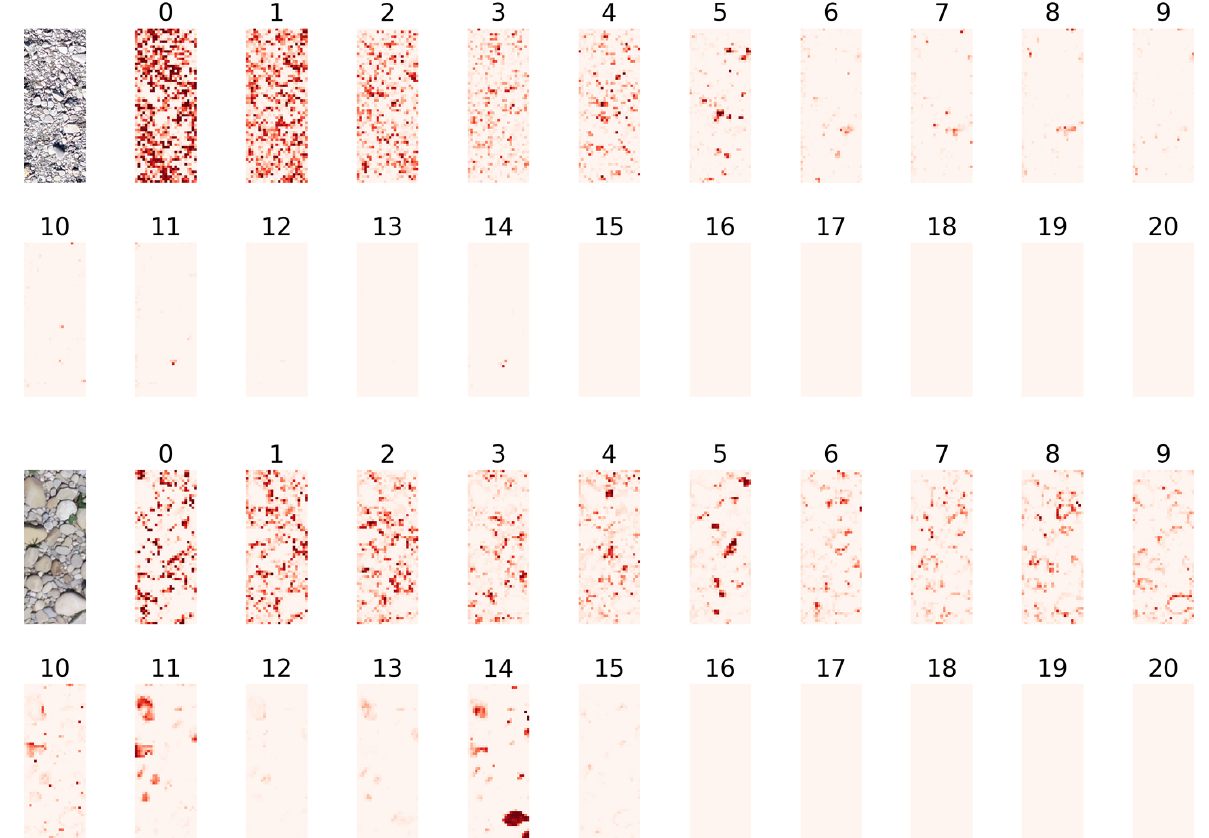
Figure 10. Activation maps after the last convolutional layer for two examples. Each of the 21 maps corresponds to a specific histogram bin of the grain size distribution, where bin 0 corresponds to the smallest and bin 20 to the largest grains. Light colors are low activation, and darker red denotes higher